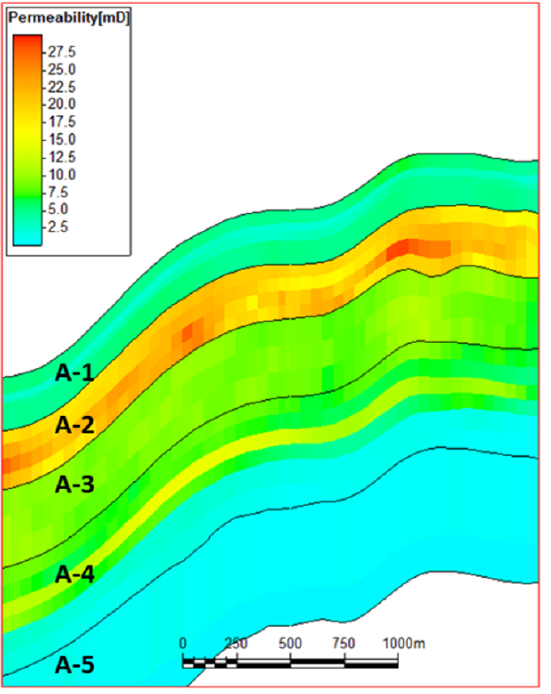
Figure 1. Permeability contrast diagram of each small layer in A reservoir.